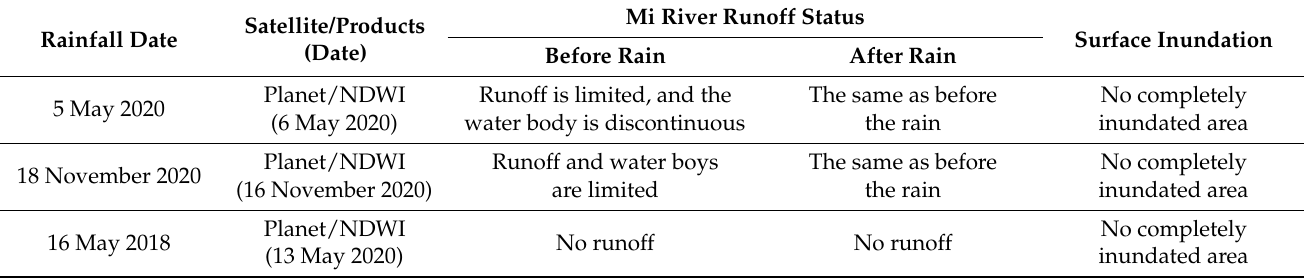
Table 6. Mi River runoff status with five rainfall